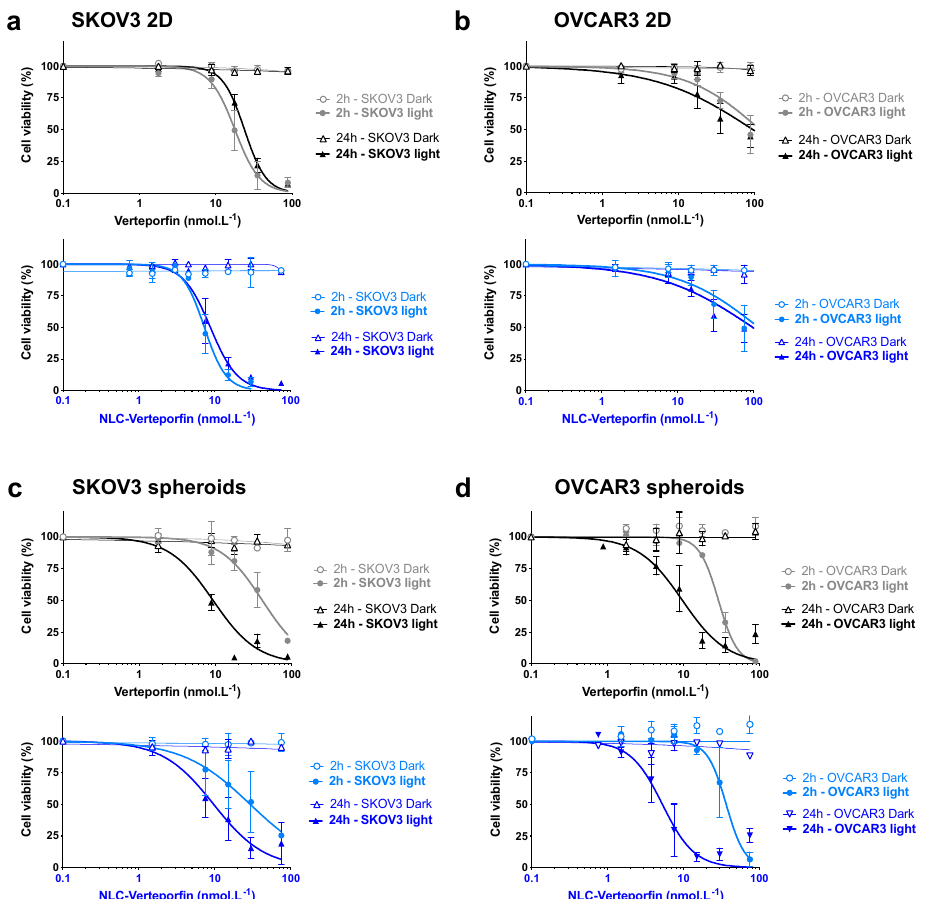
Figure 3. Verteporfin and NLC-verteporfin mediated phototoxicity in SKOV3 and OVCAR3 cells and spheroids. SKOV3 (left panels) and OVCAR3 (right panels) cells ( a , b ) or spheroids ( c , d ) were treated with increasing concentrations of free verteporfin (in grey/black) or NLC-verteporfin (in blue) for 2 h or 24 h before NIR light exposure at 690 nm (fluency 10 J.cm − 2 ). In parallel, cells or spheroids were maintained in the dark. ( a , b ) Cell viability was assessed 72 h following light exposure. Data are expressed as the mean ± SD of ≥ 3 independent experiments. ( c , d ) Cell viability in spheroids was assessed 72 h following light exposure. Data are expressed as the mean ± SD of ≥ 3 independent experiments in triplicate. Table 2. Sensitivity of ovarian cancer cells to verteporfin and NLC-verteporfin. Cell Lines Cell